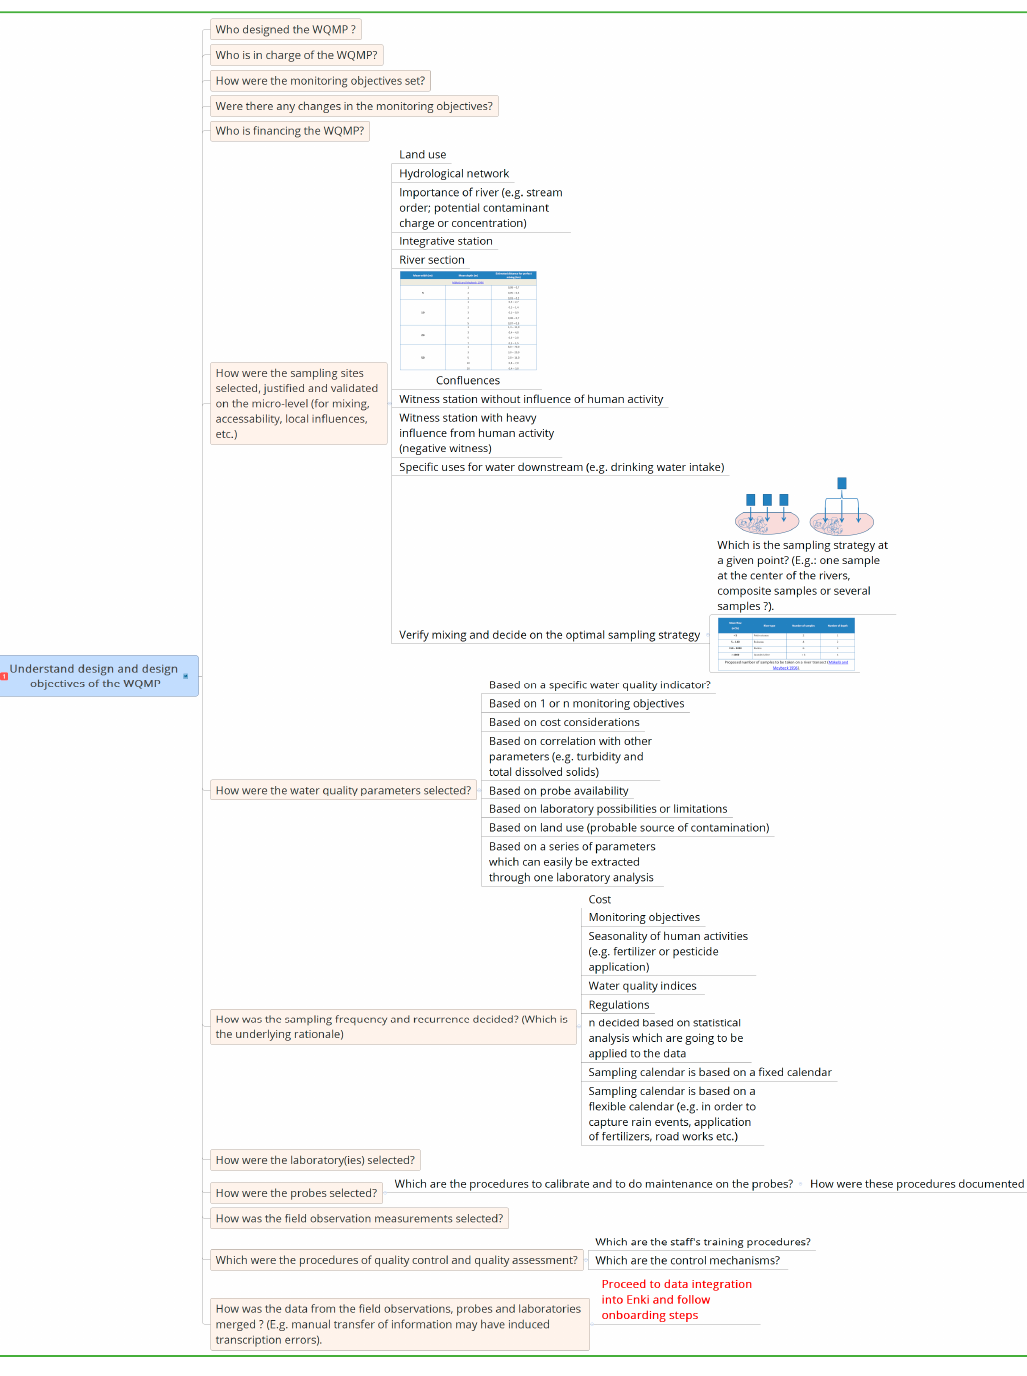
Figure 4. Questions to be asked (and integrated) into the system in order to understand the design of a WQMP.